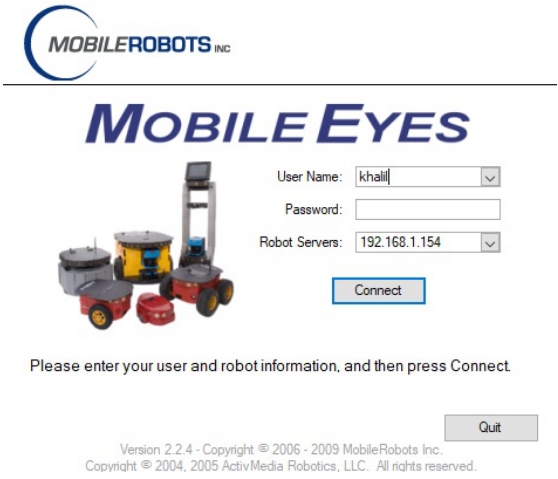
Figure 2. MobileEyes graphical user